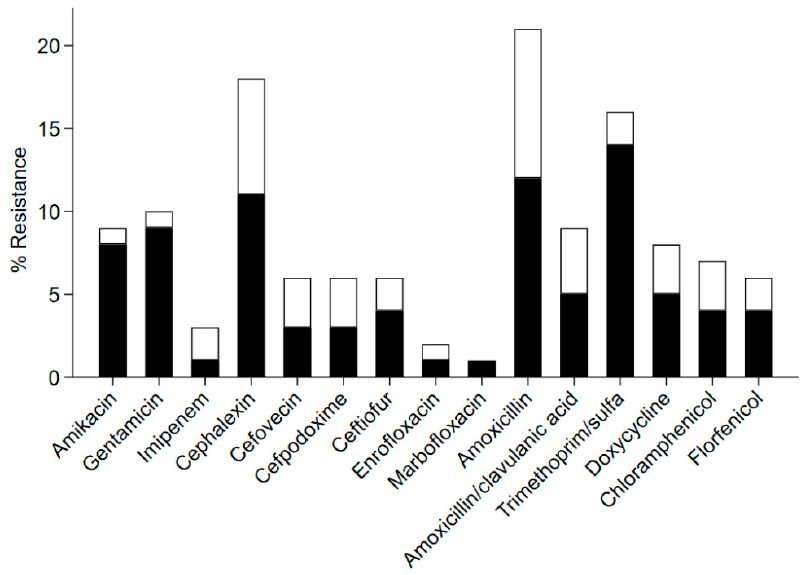
Figure 3. Percentage of bacterial isolates from harbor seals (black) and harbor porpoises (white) displaying resistance to individual antibiotics, grouped by class.